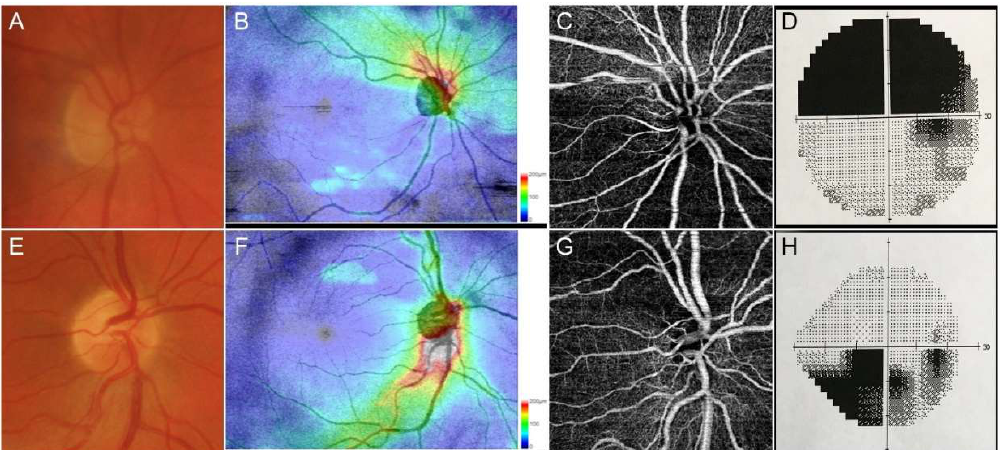
Figure 1. Representative cases of anterior ischemic optic neuropathies. Anterior ischemic optic neuropathies (AAION) case showed a marked involvement of optic nerve head ( A ), with a strong damage of retinal nerve fiber layer (RNFL) ( B ), together with sectorial optical coherence tomography angiography (OCTA) perfusion impairment ( C ) and superior visual field defects ( D ). Non-anterior ischemic optic neuropathies (NAION) cases showed a less extensive optic nerve head ( E ) and RNFL ( F ) involvement, with a well-detected OCTA perfusion damage ( G ) and circumscribed visual field defect ( H ).